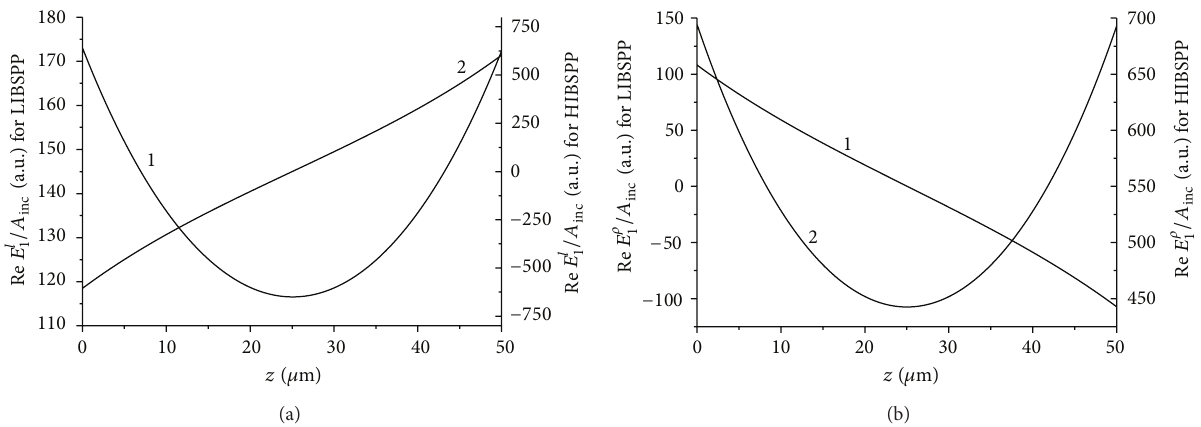
𝜌 Figure 3: The normalized real part of the longitudinal 𝐸 𝑙 1 (a) and radial 𝐸 1 (b) components of the electric vector for low-index (1) and high- index (2) TM-polarized zero-order Bessel surface plasmon polaritons versus the distance inside the gold film of 50nm thickness embedded in SF10 glass. The distance from the Bessel surface plasmon polariton axis is 𝜌 = 0.05 𝜇 m, and the wavelength is 𝜆 = 0.633 𝜇 m.